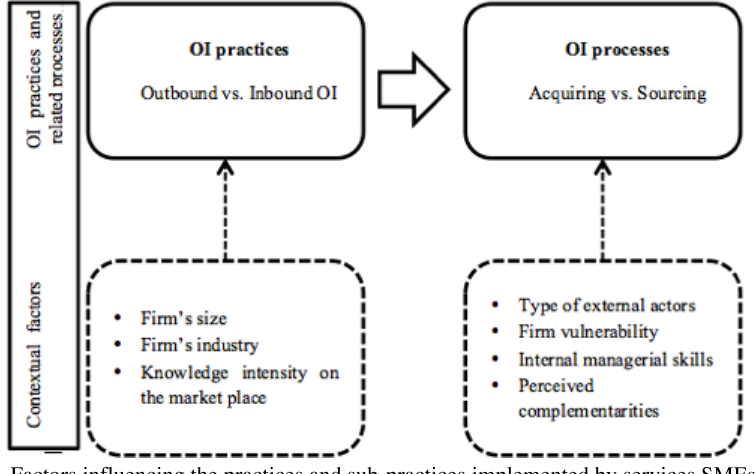
Fig. 2. Factors influencing the practices and sub-practices implemented by services